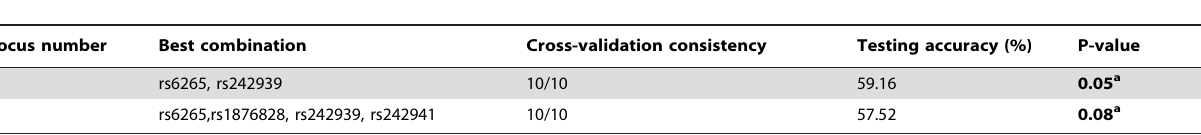
Table 3. Best gene–gene interactions models identified by the generalized multifactor dimensionality reduction (GMDR) method.